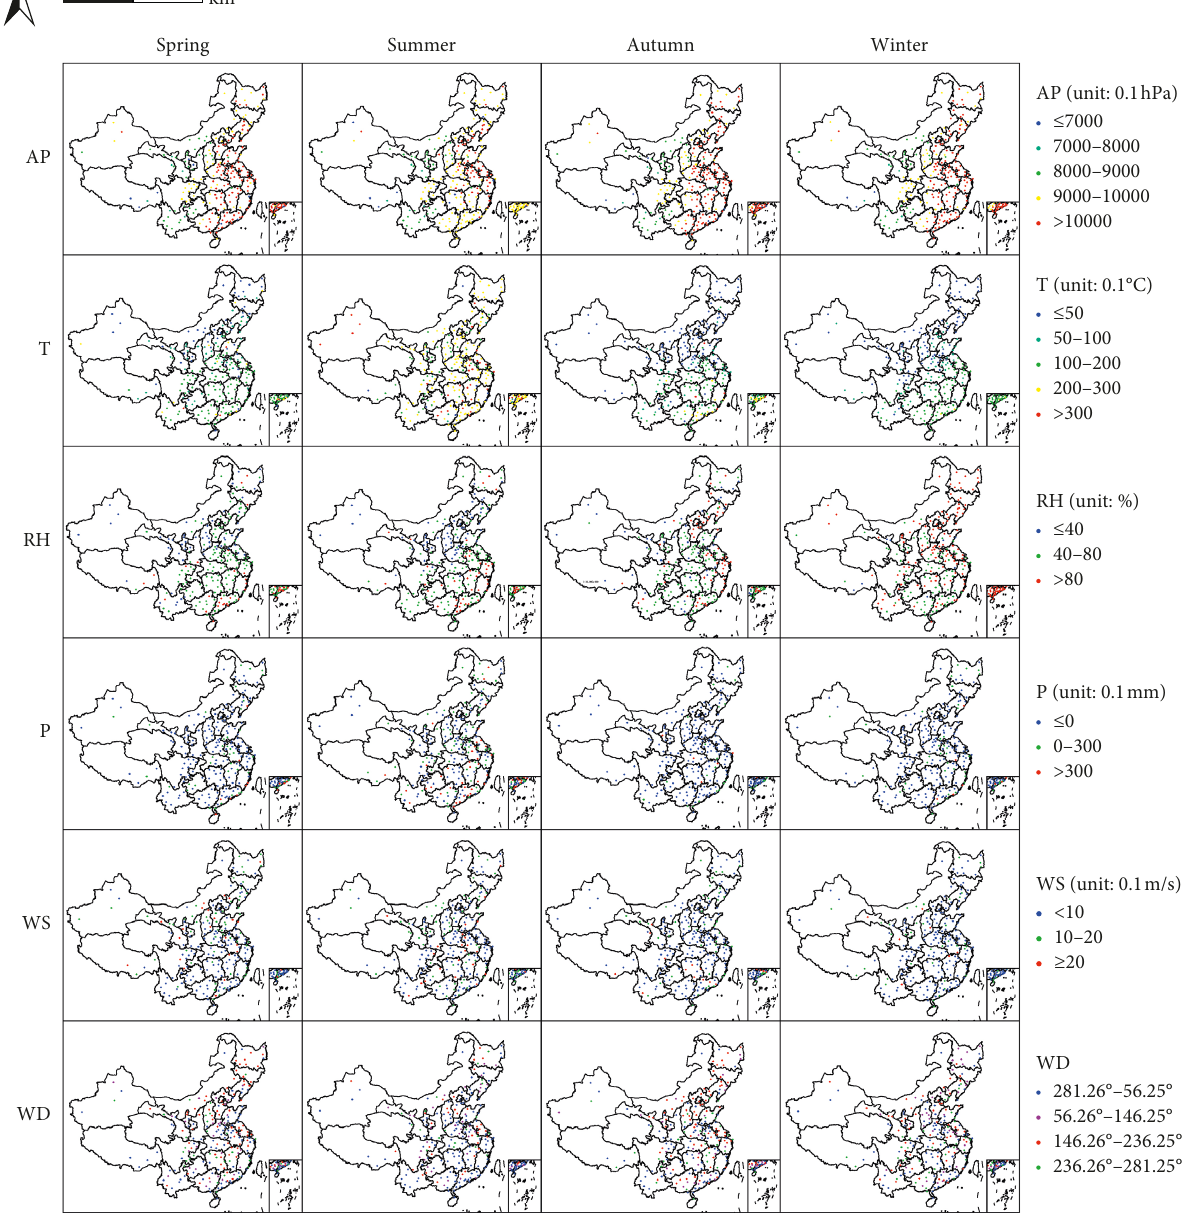
Figure 20: Spatial pattern of the impact of meteorological factors on NO